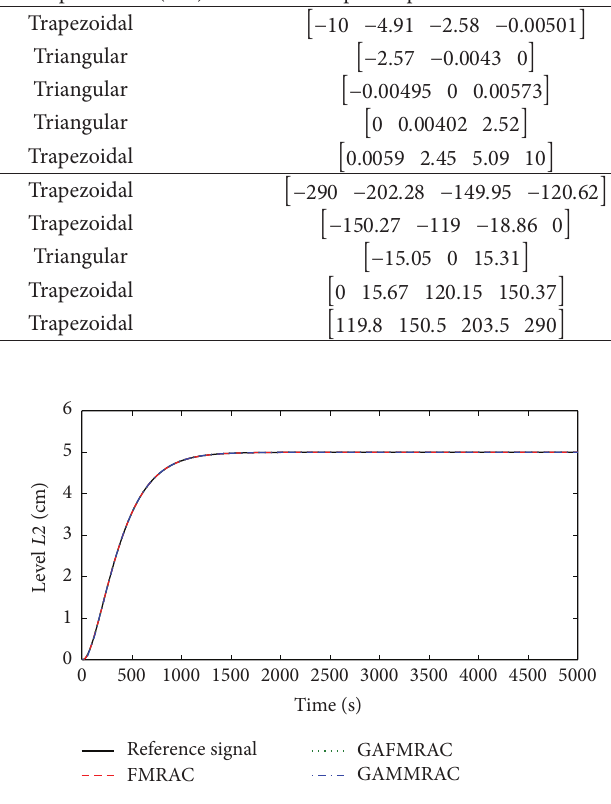
Figure 6: Response of the three controllers for a step change in set point.